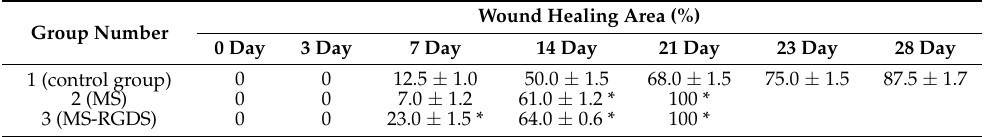
Figure 4. Images of wounds on days 0, 3, 7, 14, 21, 23, and 28 of the experiment. Complete healing of the wound in the control group occurred on the 40th day of the experiment (image not shown). Table 3. Dynamics of full-thickness skin wound healing in Wistar rats (standard deviation values for 5 independent measurements are shown). Sign “*” indicates statistically significant differences between the experimental groups and the control